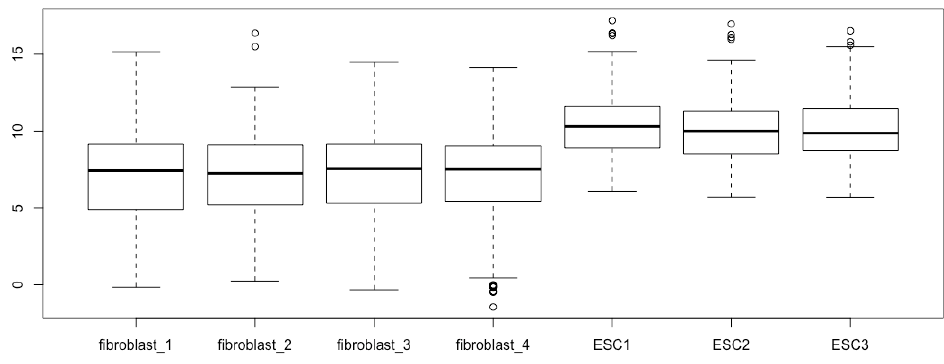
Figure 3. Prepare boxplots using the log2-transformed read counts for enhanced resolution.